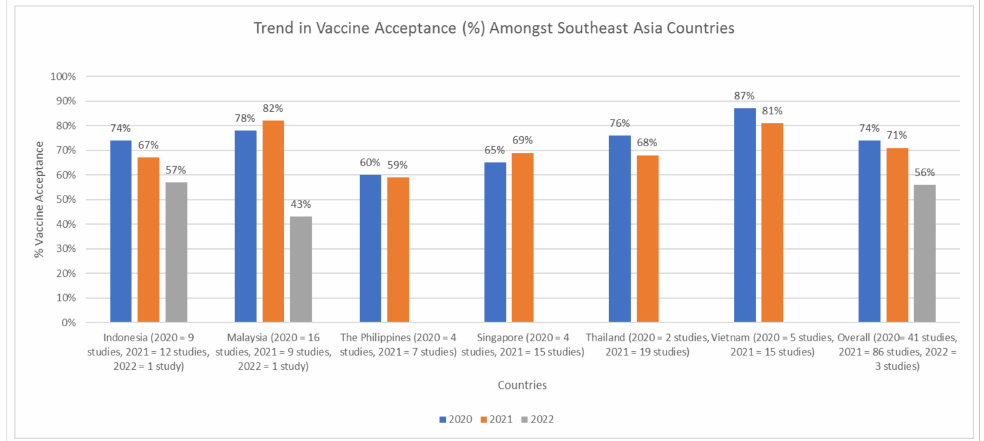
Figure 3. Trends in vaccine acceptance changes amongst South East Asian countries between 2020 and